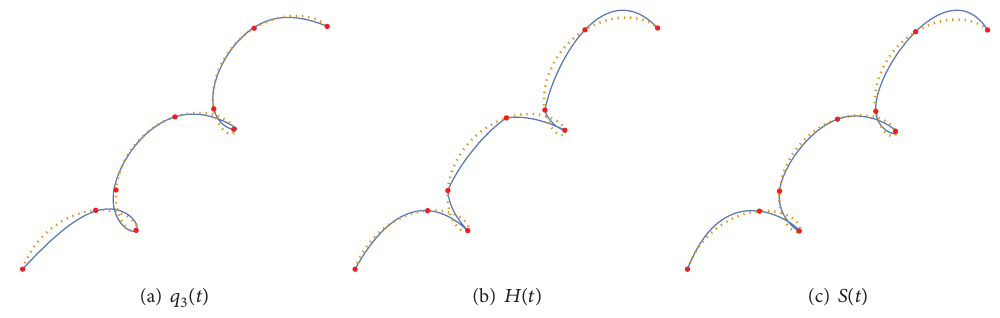
Figure 7: Comparison of the presented approximation 𝑞 3 (𝑡) , Hermite interpolation 𝐻(𝑡) , and spline interpolation 𝑆(𝑡) for the parametric function 𝑟(𝑡) with 𝑁 = 2 3 . Dotted curves indicate the original graph of 𝑟(𝑡)